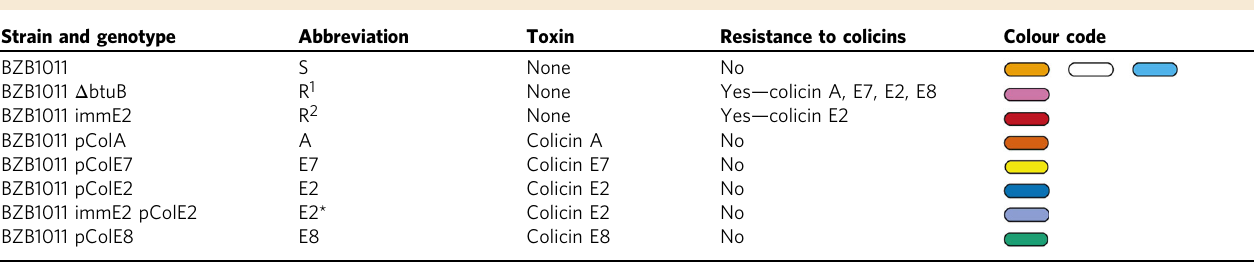
Fig. 2 Micron-scale structure shapes competition between susceptible and colicin-producing strains by creating ecological refuges. a The characteristics of each colicin-producing strain used in this study. 1 The ‘ killing rank ’ ranks the ability of each of the colicin-producing strain to kill colicin- susceptible strains, see refs. 49,52 and data therein. b , c A schematic hypothesis, of how susceptible and colicin-producer frequencies change over time, in a genetically mixed spatial structure ( SI = 0.50) ( b ), and in a genetically segregated spatial structure ( SI = 0.94) ( c ), if susceptible growth rates outweigh the cost of toxin production. d , Segmented fl uorescence images of S cells (white) and E7 cells (yellow) in communities printed at an initial SI of 0.50 ( n = 6), 0.67 ( n = 3), 0.88 ( n = 3) and 0.94 ( n = 6) with accompanying printing maps. A Kruskal Wallis test showed a statistically signi fi cant relationship between the change in frequencies of S with SI (Kruskal – Wallis statistic: 15.63, P < 0.001, see Supplementary Table 2 for the statistical test). e – g Segmented fl uorescence images of S cells (white) and A cells (vermillion) ( n = 3 and n = 4 for SI = 0.50 and 0.94, respectively) ( e ), and E2 cells (blue) ( n = 4 and n = 10 for SI = 0.50 and 0.94, respectively) ( f ), and E8 cells (bluish-green) ( n = 7 and n = 7 for SI = 0.50 and 0.94, respectively) ( g ), in communities printed at an initial SI = 0.50 and 0.94. h Segmented fl uorescence images of E2 cells (blue) and R 1 cells (reddish-purple) in communities printed at an initial SI of 0.50 ( n = 9) and 0.94 ( n = 6). In d – h , each fl uorescently segmented image was taken after 18 h of competition. Below each fl uorescently segmented imaged is a stacked bar chart of the frequencies of strains in the array. Each data point represents a biologically independent replicate; the mean frequencies of each strain are where the bars meet. In e – h , unpaired Mann – Whitney tests were performed to assess the statistical signi fi cance of the changes in frequencies of competing strains at different SI values. For e , P = 0.6286; for f , P = 0.0020; for g , P = 0.4462; for h , P = 0.0336 (see Supplementary Tables 3 for statistical tests). In h , one-sample t and Wilcoxon tests showed a statistically signi fi cant ( P = 0.0039) and non- signi fi cant ( P > 0.6250) difference between the median frequencies of E2 and R 1 at SI = 0.50 and 0.94, respectively (see Supplementary Tables 3 for